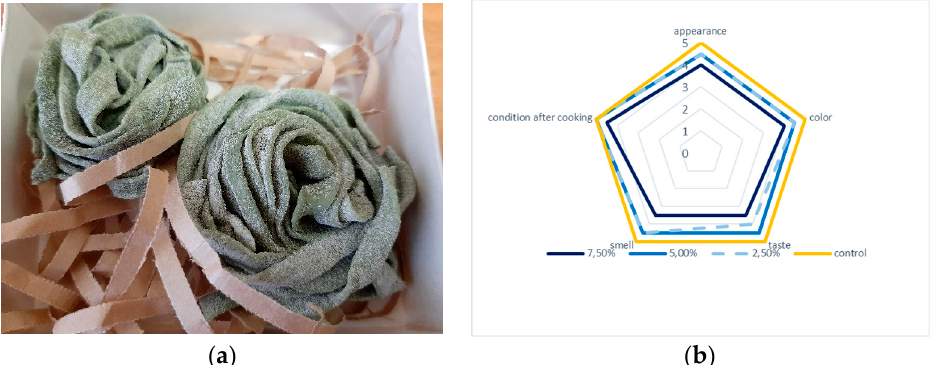
Figure 2. Results of sensory evaluation of finished pasta with replacement of flour with dry biomass of microalgae C. sorokiniana ( a ) and tagliatelle samples with 5% biomass additives ( b ). Pasta with microalgae biomass additives had a color from light green to intense green, depending on the amount of additive. It was noted that the samples of pasta with the addition of more than 5% of biomass had a significant fishy flavor. Thus, the addition of microalgae in an amount of more than 5% is impractical.